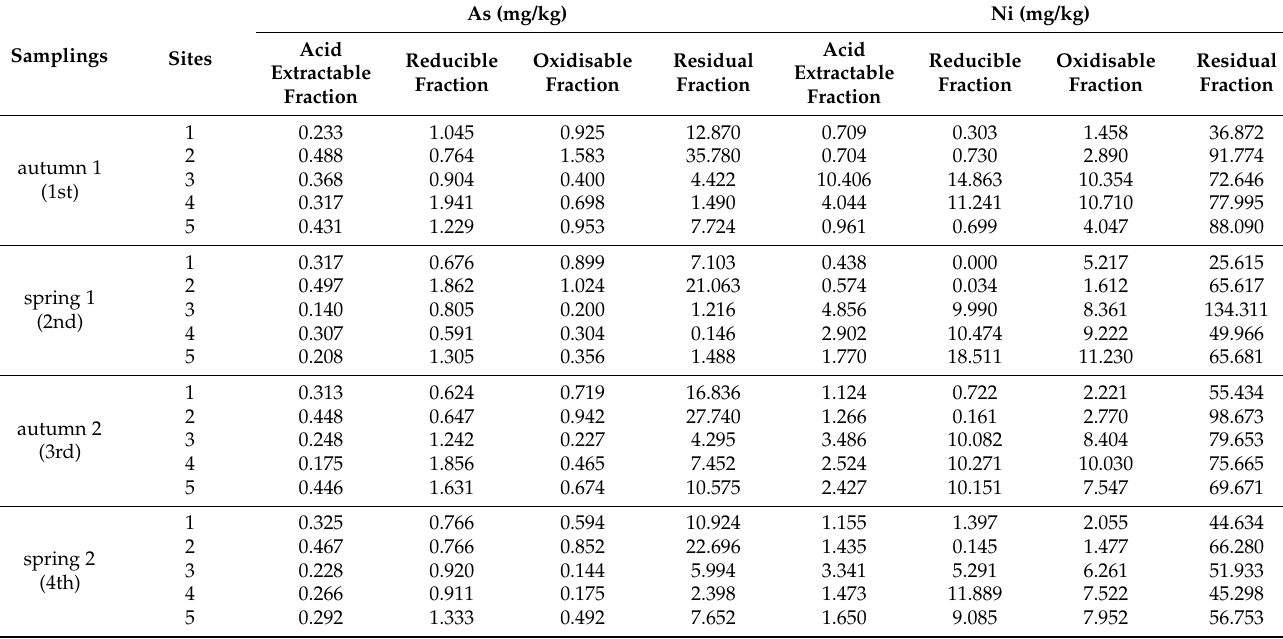
Table A3. Concentrations of As (mg/kg) and Ni (mg/kg) in the different fractions of sediments from Algeciras Bay.